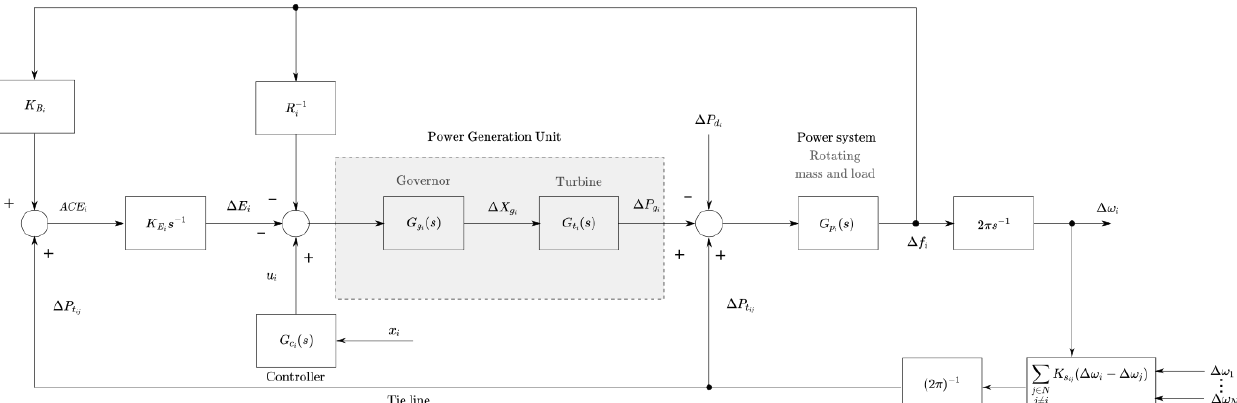
Figure 1. i -tharea model of the N -area power